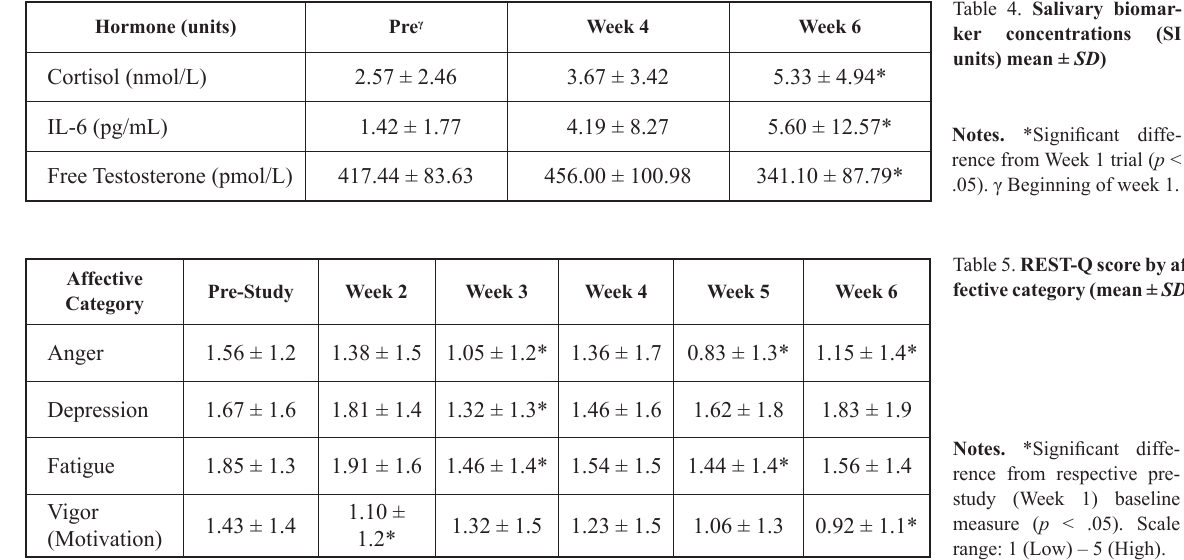
Table 4. Salivary biomar-